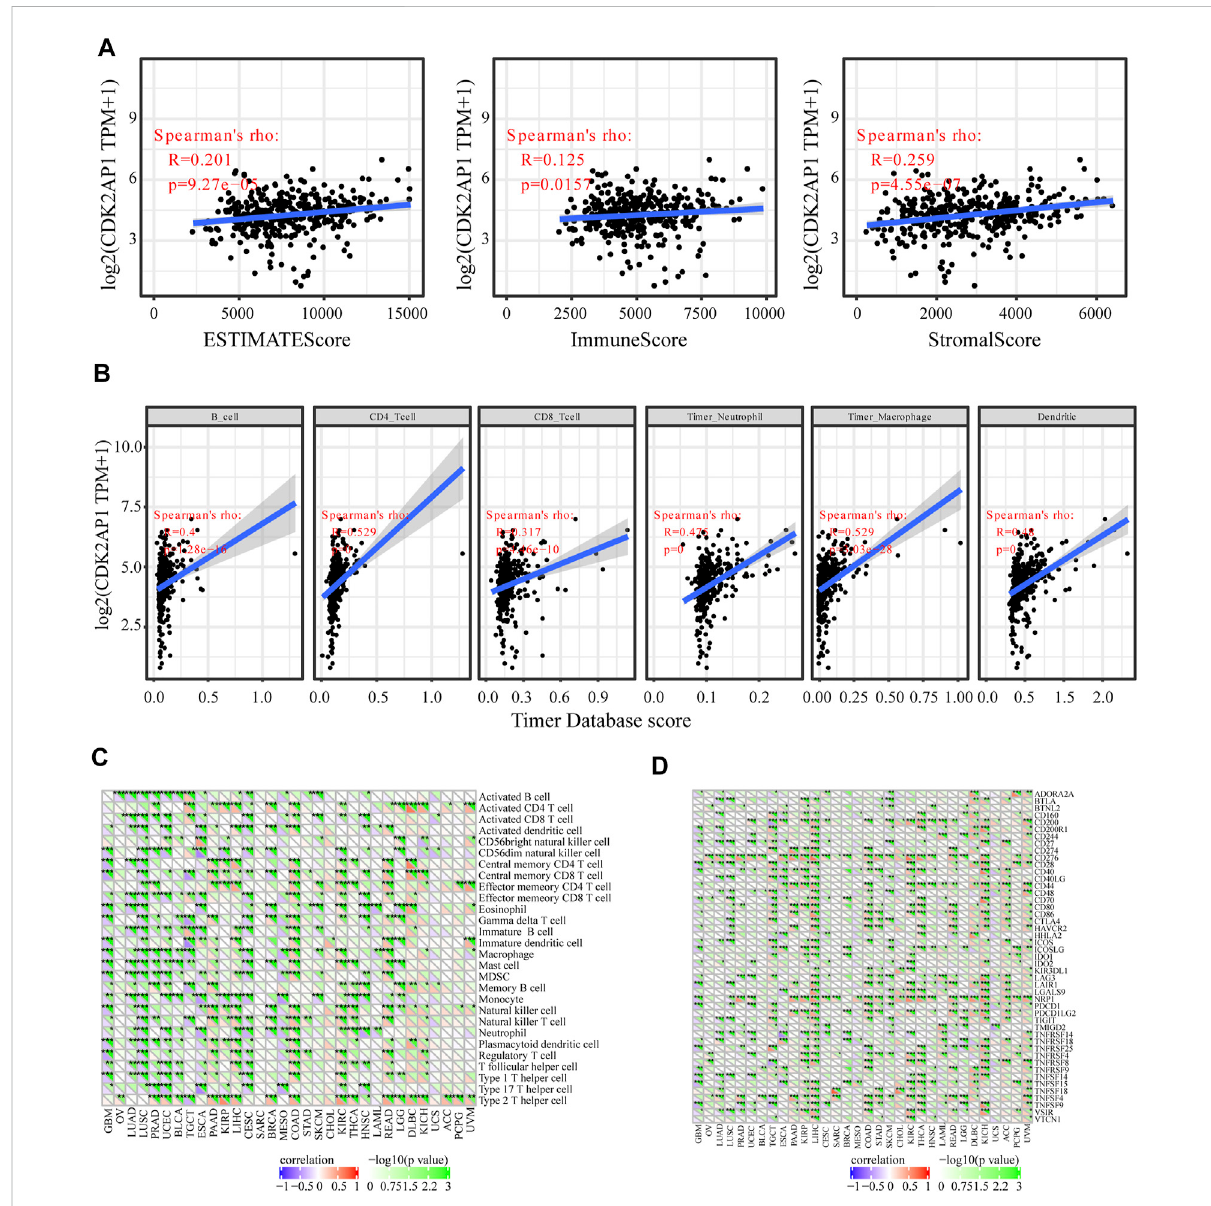
FIGURE 4 Immunologicalaspectsrelatedto CDK2AP1 inLIHC (A) Thecorrelationanalysisof CDK2AP1 expression and in fi ltratingstromal/immune cells in tumor tissues using ESTIMATE algorithm (B) the correlation analysis of CDK2AP1 expression and composition of in fi ltrating immune cells in tumor samples (C) Thecorrelationanalysisof CDK2AP1 expressionandacknowledgedmarkersofimmunepathway (D) Thecorrelationanalysisof CDK2AP1 expression and immune checkpoint genes. * p < 0.05, ** p < 0.01 and *** p <